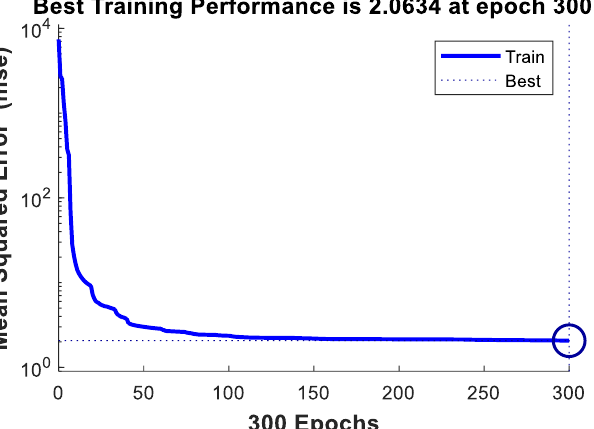
Figure 7. Performance of the ANN-based speed estimator considering mean squared error (MSE).